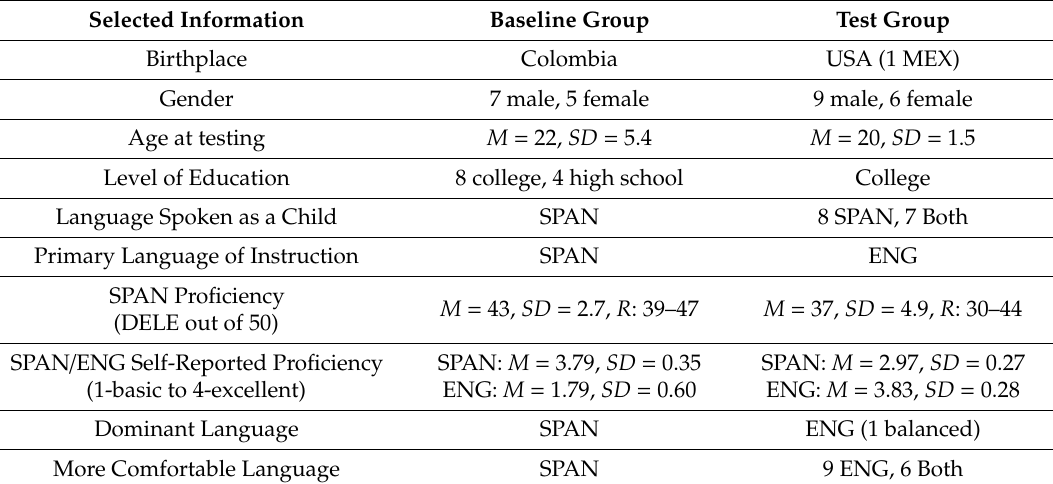
Table 1. Participant